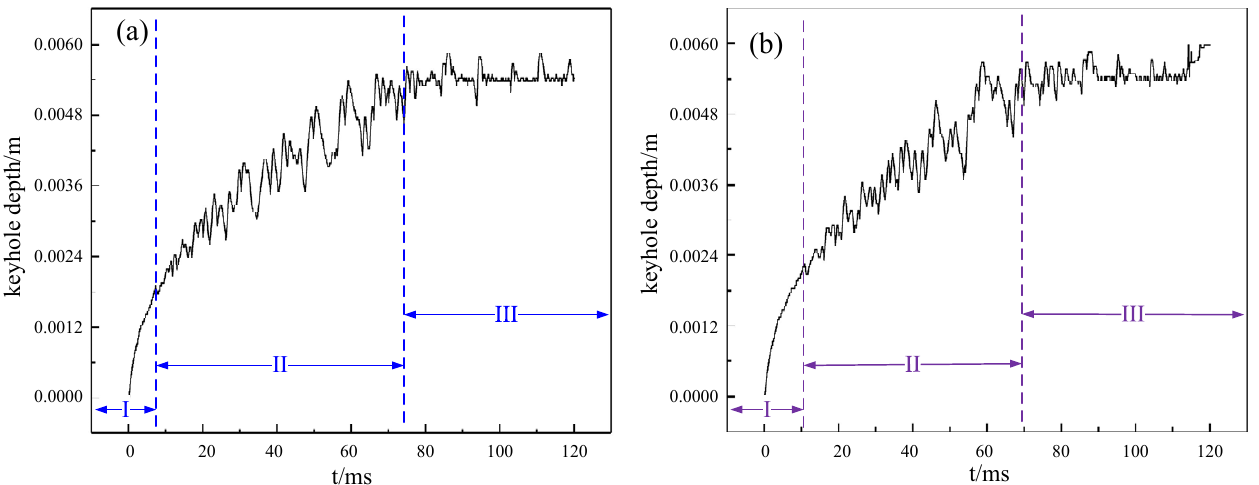
Figure 12. Keyhole depth fluctuation under different welding speeds. ( a ) v = 1.5 m/min; ( b ) v = 1.2 m/min.